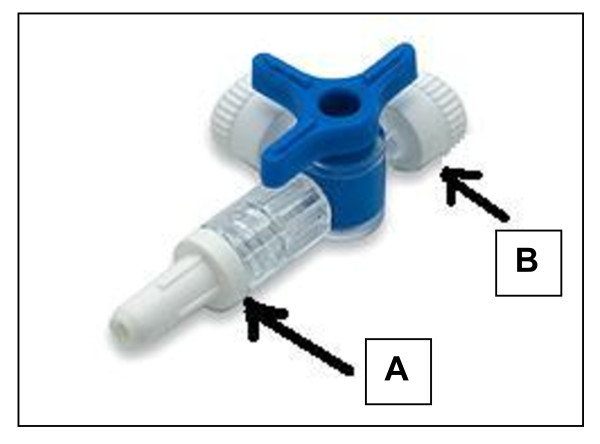
Threeway stopcock.